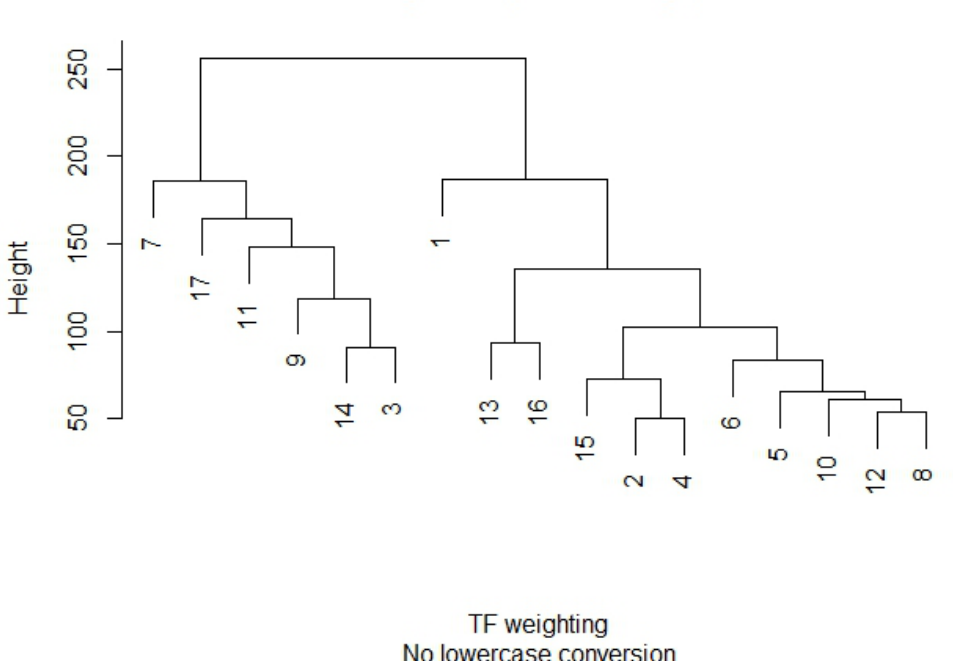
Figure 4: Hierarchical clustering using the complete linkage method with Euclidean distance. Again, the six V. storyline chapters can be seen to occupy their own dedicated (left) branch of the